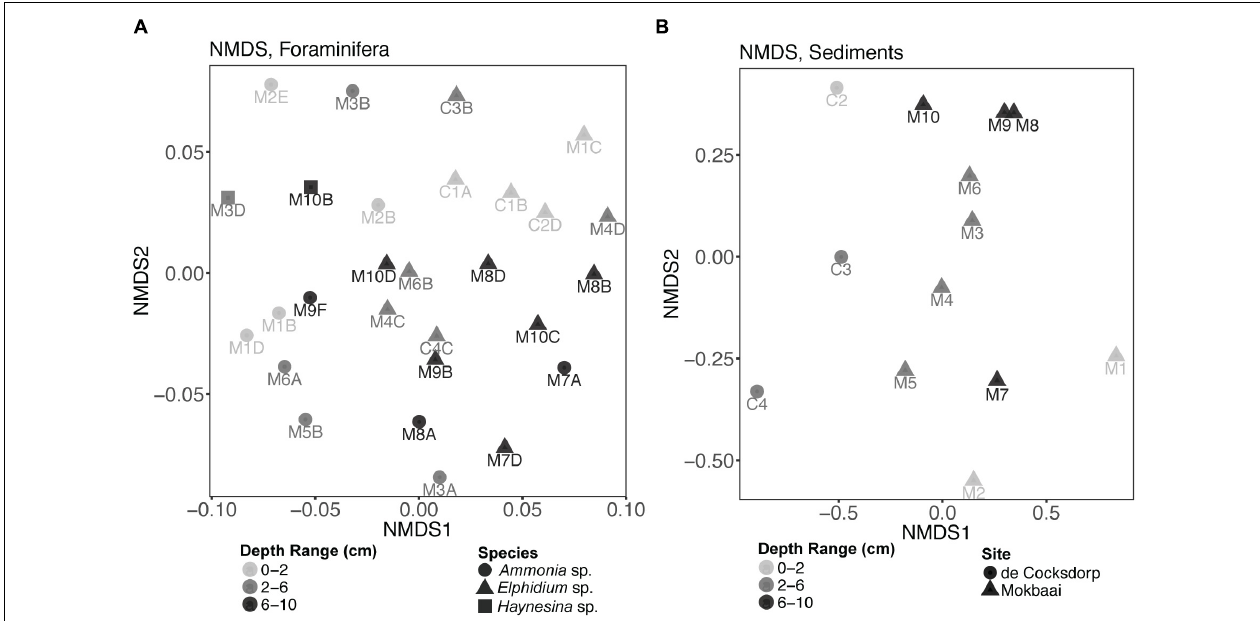
FIGURE 4 | Non-metric multidimensional scaling (nMDS) plots of (A) foraminiferal intracellular eukaryote content (excluding foraminiferal OTUs) and (B) communities of the surrounding sediments. Samples from different sediment depths (cm) are grouped in three depth ranges: 0–2, 2–6, and 6–10 cm. “M” indicates foraminiferal specimens and sediment samples from Mokbaai; “C” indicates foraminiferal specimens and sediment samples from de Cocksdorp. nMDS was based on a Bray-Curtis distance and the stress for foraminifera was 0.2243, whereas for sediments